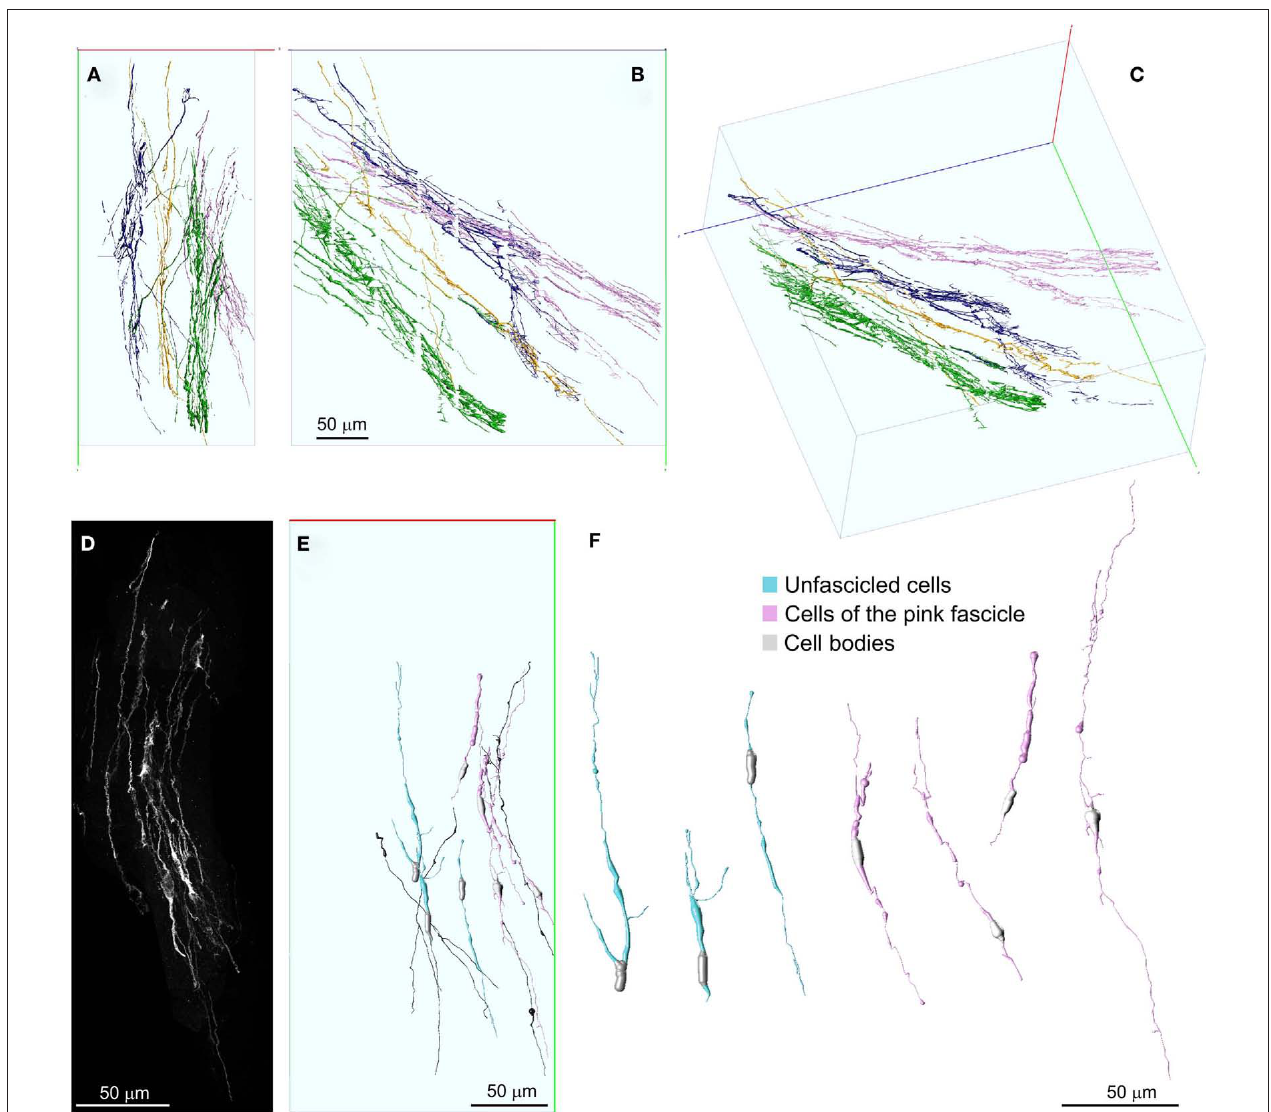
fascicle after a manual cut-off of surrounding areas section by section. (e, F) 3D reconstructions of individual DCX + cells isolated (cyan) or being part of the pink colored fascicle (pink). Some individual DCX + process, whose cell body was not included in the reconstructed volume, are also shown (dark) in (e) . These cells were reconstructed in Neuromantic and rendered in V3D neuron . Note these cells are mostly bipolar and show long and poorly ramified processes. Orientation Bars: gray line: medial; cyan line: dorsal; dark line: